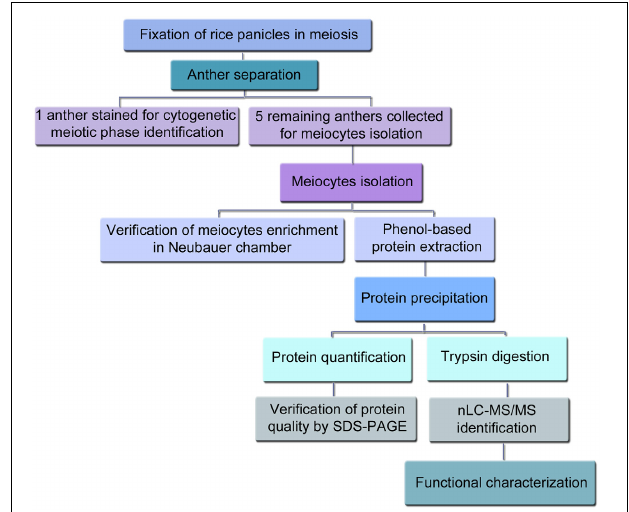
FIGURE 1 | Flow chart overview for the extraction of rice meiocytes in prophase I, the subsequent proteomics experiments and the data